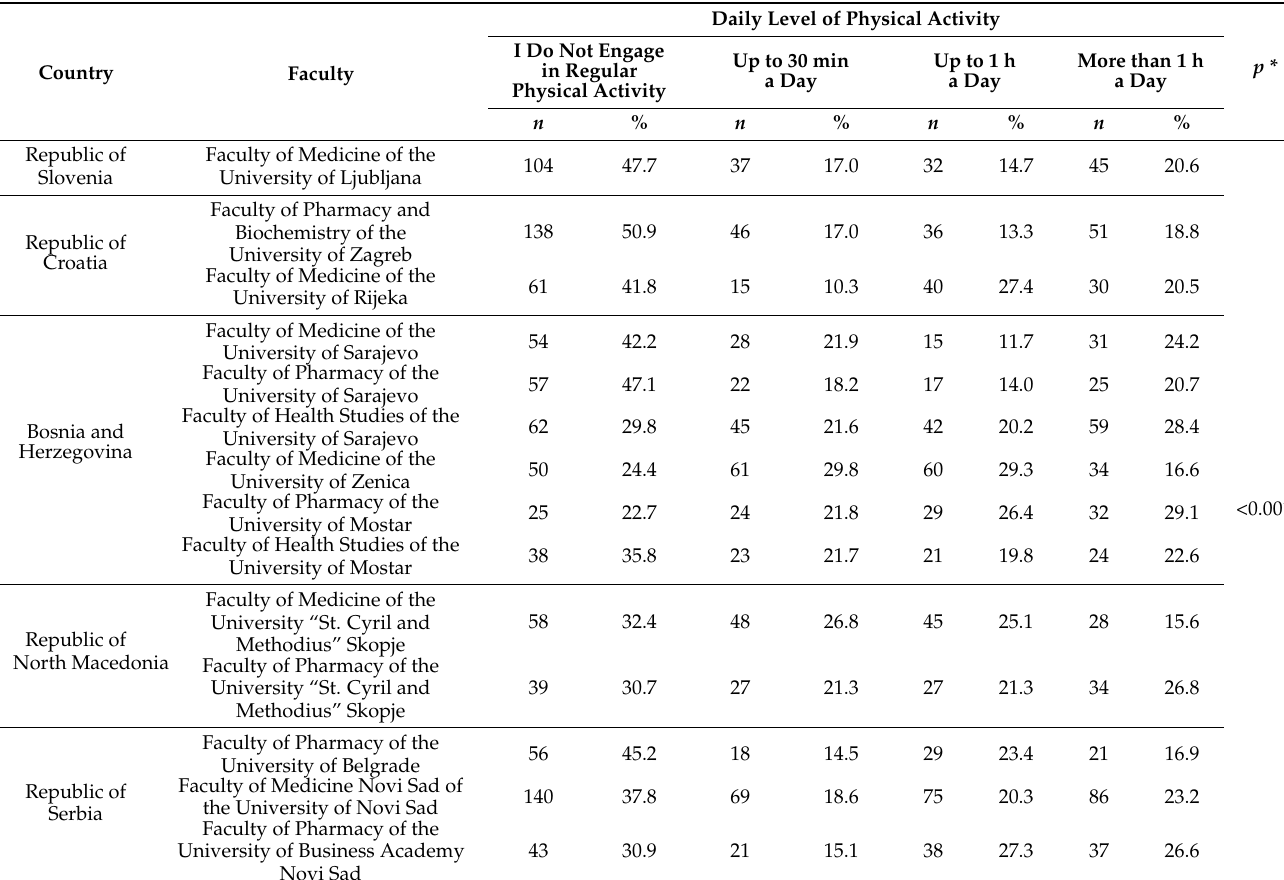
Table 3. Daily level of physical activity of medical students from different medical